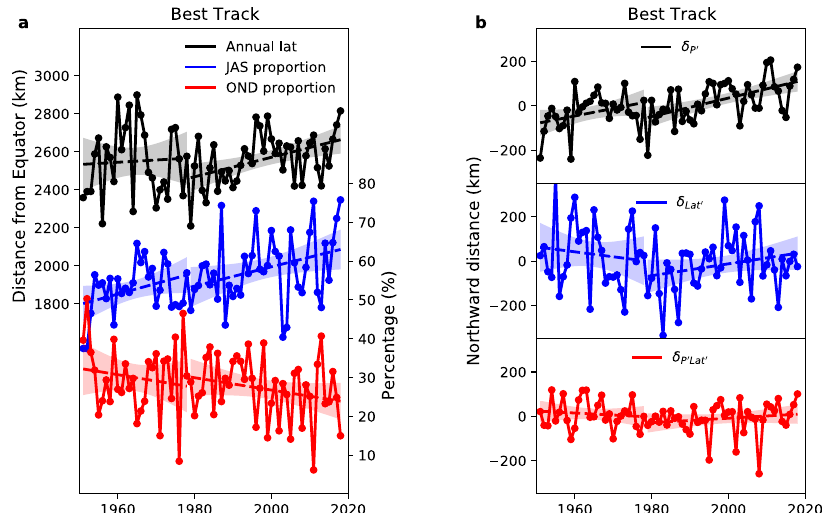
Fig. 4 Changes in annual-mean latitude of tropical cyclone all-track-points, and changes in three seasonality components, over the extended period 1951 – 2018. a Timeseries of annual-mean latitude of all-track-points (black), and timeseries of peak-season (July – September; JAS, blue) and late-season (October – December; OND, red) relative frequencies of all-track-points in the year, in two epochs (the pre-satellite era 1951 – 1978 and the satellite era 1979 – 2018) of the whole period 1951 – 2018, in the Best Track ensemble mean. b Decompositions of annual-mean latitude of all-track-points by three seasonality contributing components, representing the effects of departures (from the respective time means) of monthly relative frequency ( δ P 0 , black), monthly latitude ( δ , blue) and the covariance of the two terms ( δ P 0 , red), respectively, in two epochs of the whole period 1951 – 2018 in the Best Track Lat 0 Lat 0 ensemble mean. Dashed lines represent the linear trend, with shading showing 95% con fi dence interval for the linear fi t; the El Niño Southern Oscillation and Paci fi c Decadal Oscillation effects are removed by a multivariate regression; latitude is converted to distance from the equator